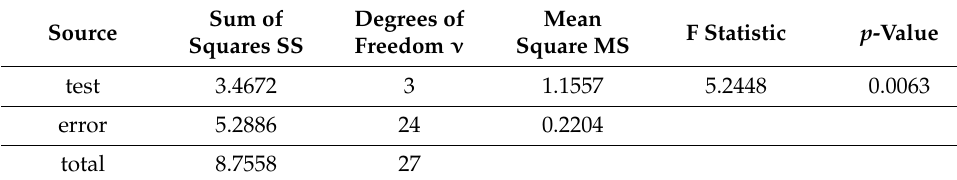
Table 6. Nausea SSQ score ANOVA